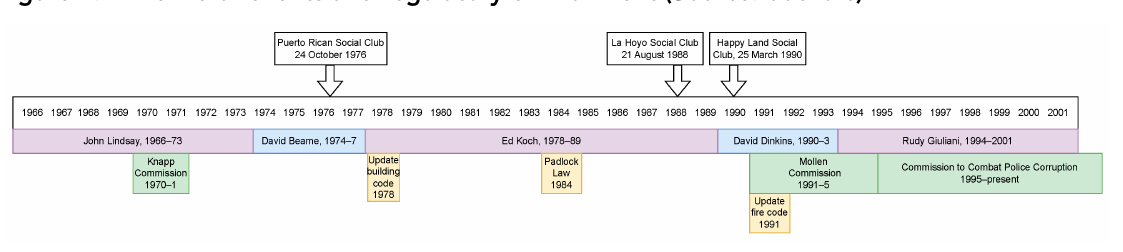
Figure 1. Timeline of events and regulatory environment (Source: